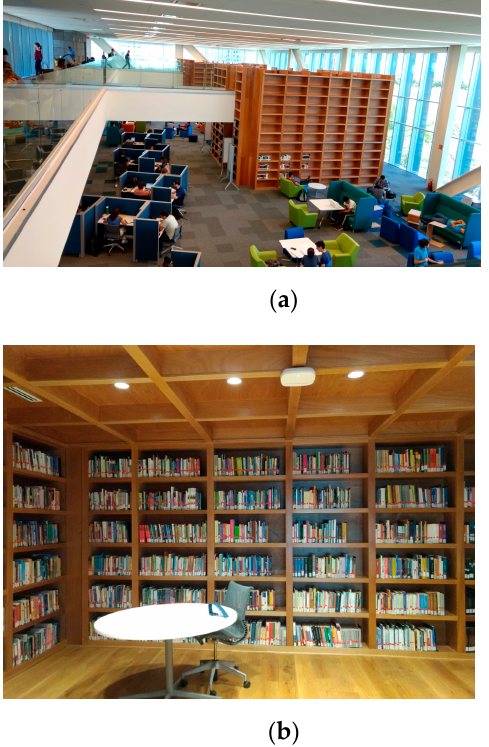
Figure 3. Considered real scenario to analyze EMF exposure with high-user density for future wireless communications systems: ( a ) aerial view of the complete scenario with two floors and ( b ) first floor inside the wooden bookshelves.